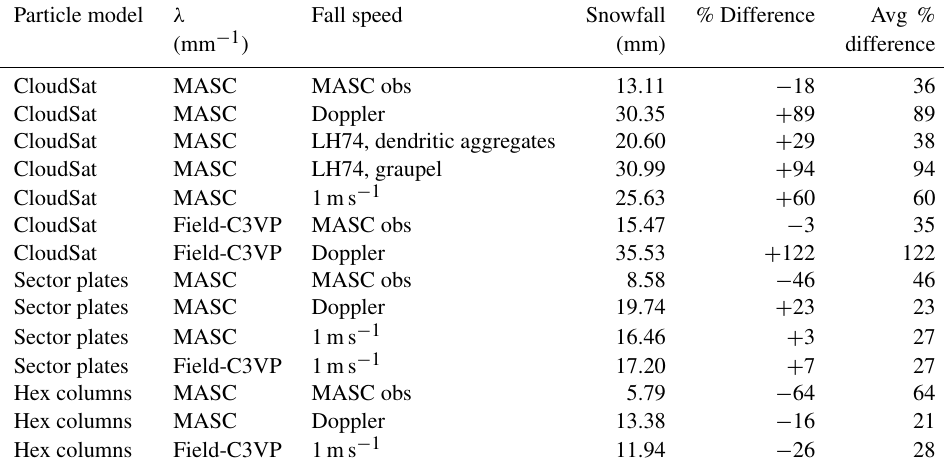
Table 4. Total retrieved snowfall amounts over five Barrow snow events for designated retrieval assumption combinations. Nearby NWS observations suggested 16mm (0.63 inches) of snowfall liquid equivalent. The MASC-derived PSD slope parameters used for these events are listed in Table 1. The “% Difference” value refers to the difference between the NWS and retrieved accumulations over the five snow events. The “Avg % difference” value refers to the average difference for the individual